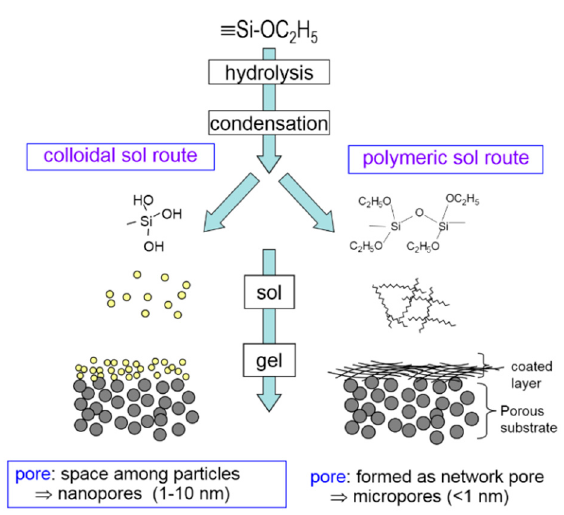
Figure 4. The colloidal and polymeric route in sol-gel process. Reproduced from [10].